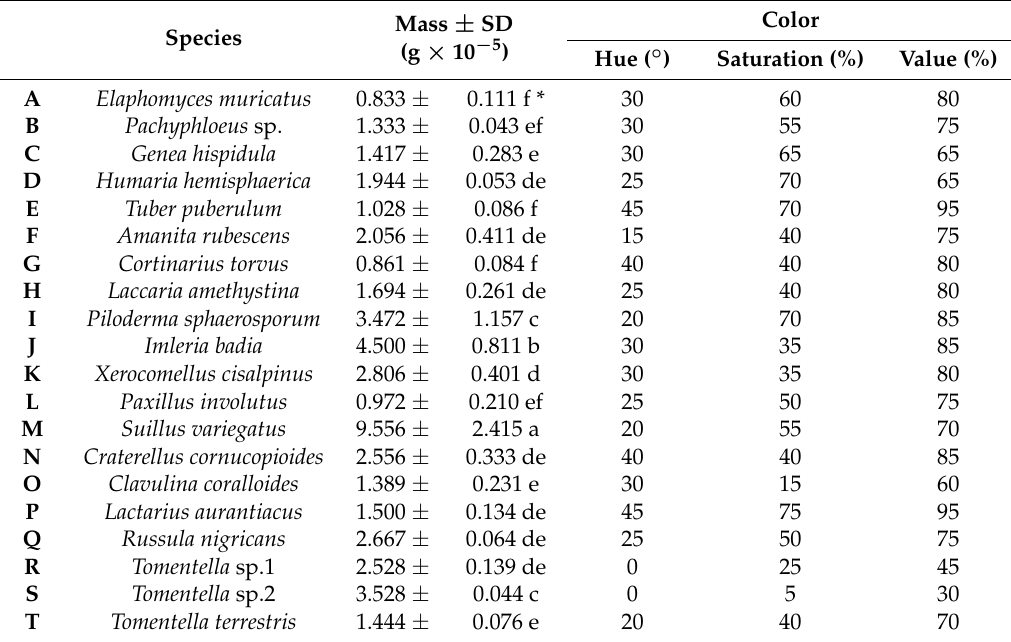
Table 2. Morphological traits of the studied ectomycorrhizal root tips: average fresh mass of the ectomycorrhizal root tip and color hue-saturation-value (HSV) coordinates. The letters ( A – T ) represent respective taxa as described in the Table 1.